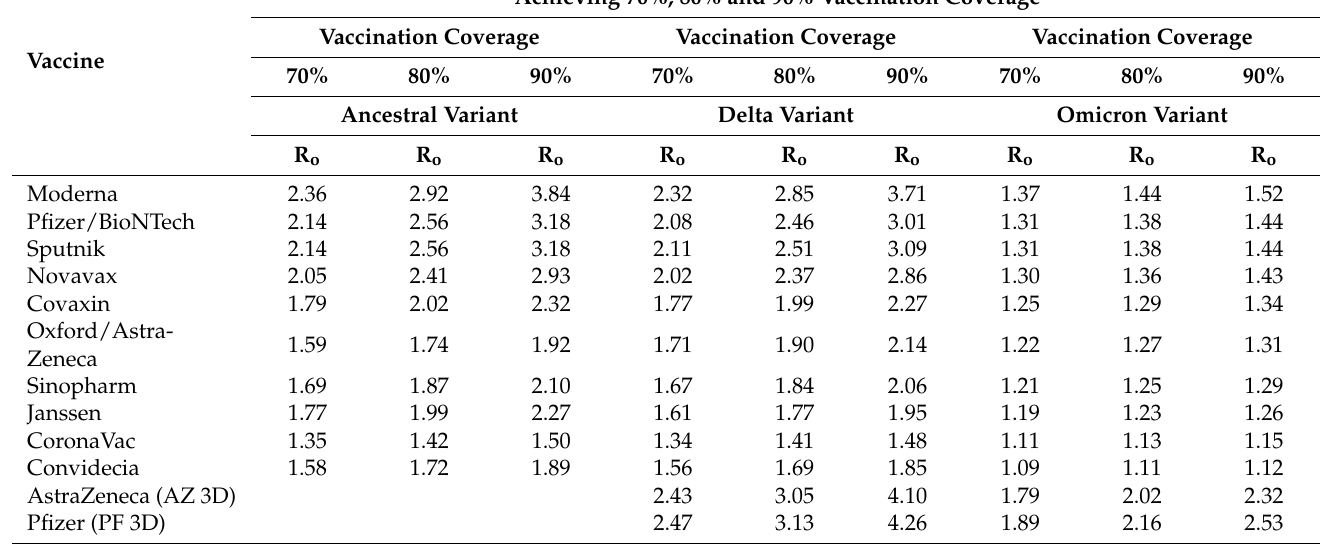
Table 5. R o of SARS-CoV-2 that COVID-19 vaccination programs could block by achieving 70%, 80%, and 90% vaccination coverage, when 9.8% of infections occur among vaccinated individuals.